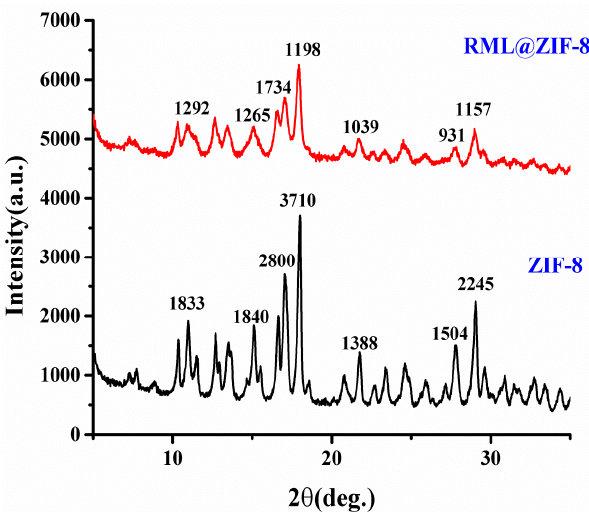
Figure 4. PXRD patterns of ZIF ‐ 8 of ZIF ‐ 8@RML.